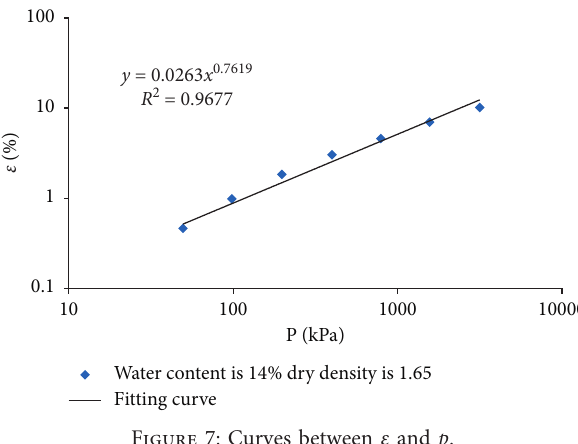
Figure 7: Curves between ε and p